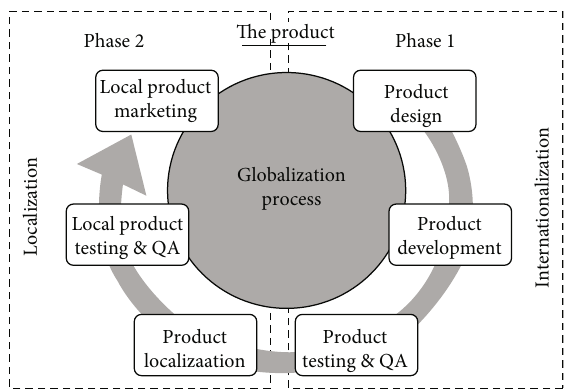
Figure 3: The global product development cycle, after Fry and Lommel